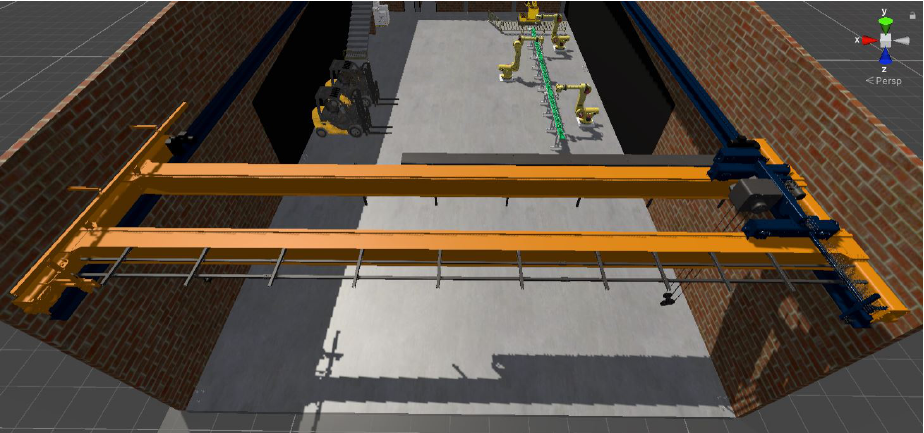
Figure 6. “Ilmatar” crane model in